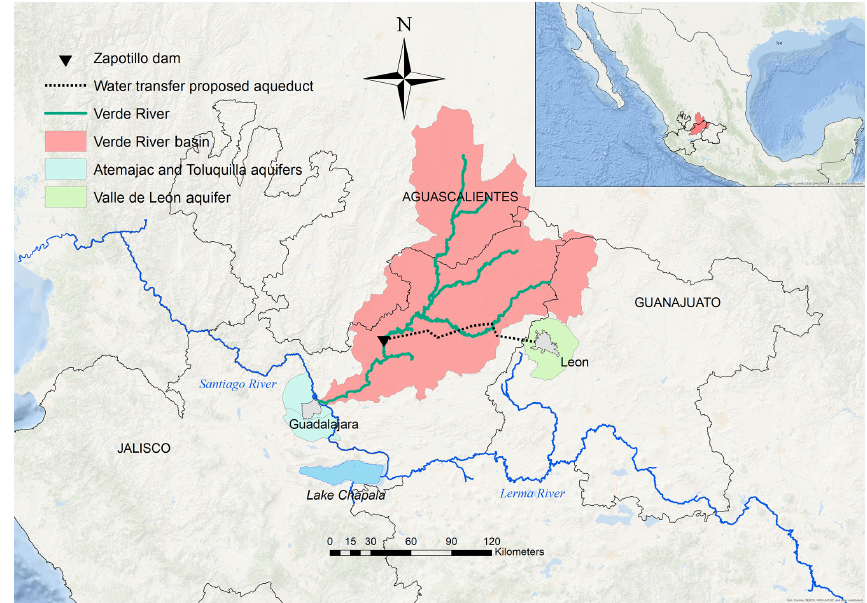
Figure 1. Map of the Verde River basin and main cities (source of GIS layers: © 2018 Conagua and © 2019 Esri, Garmin, GEBCO, NOAA NGDC, and other